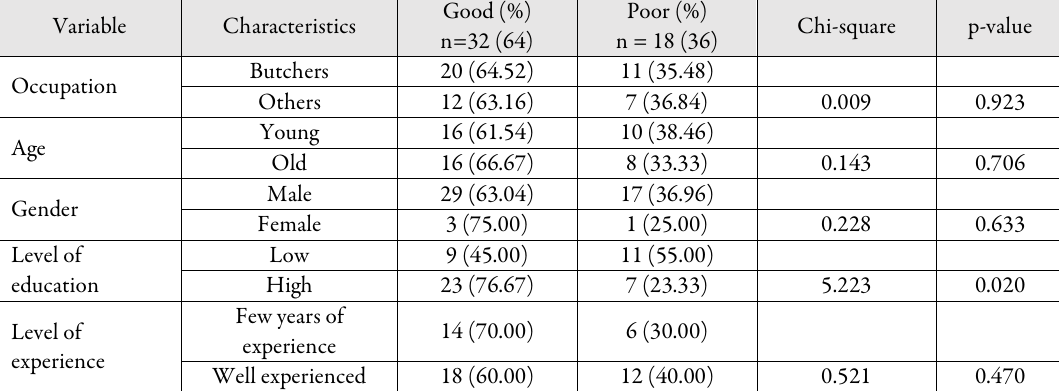
Table 4. Factors influencing levels of knowledge about ZTB among workers in Ikpa slaughterhouse